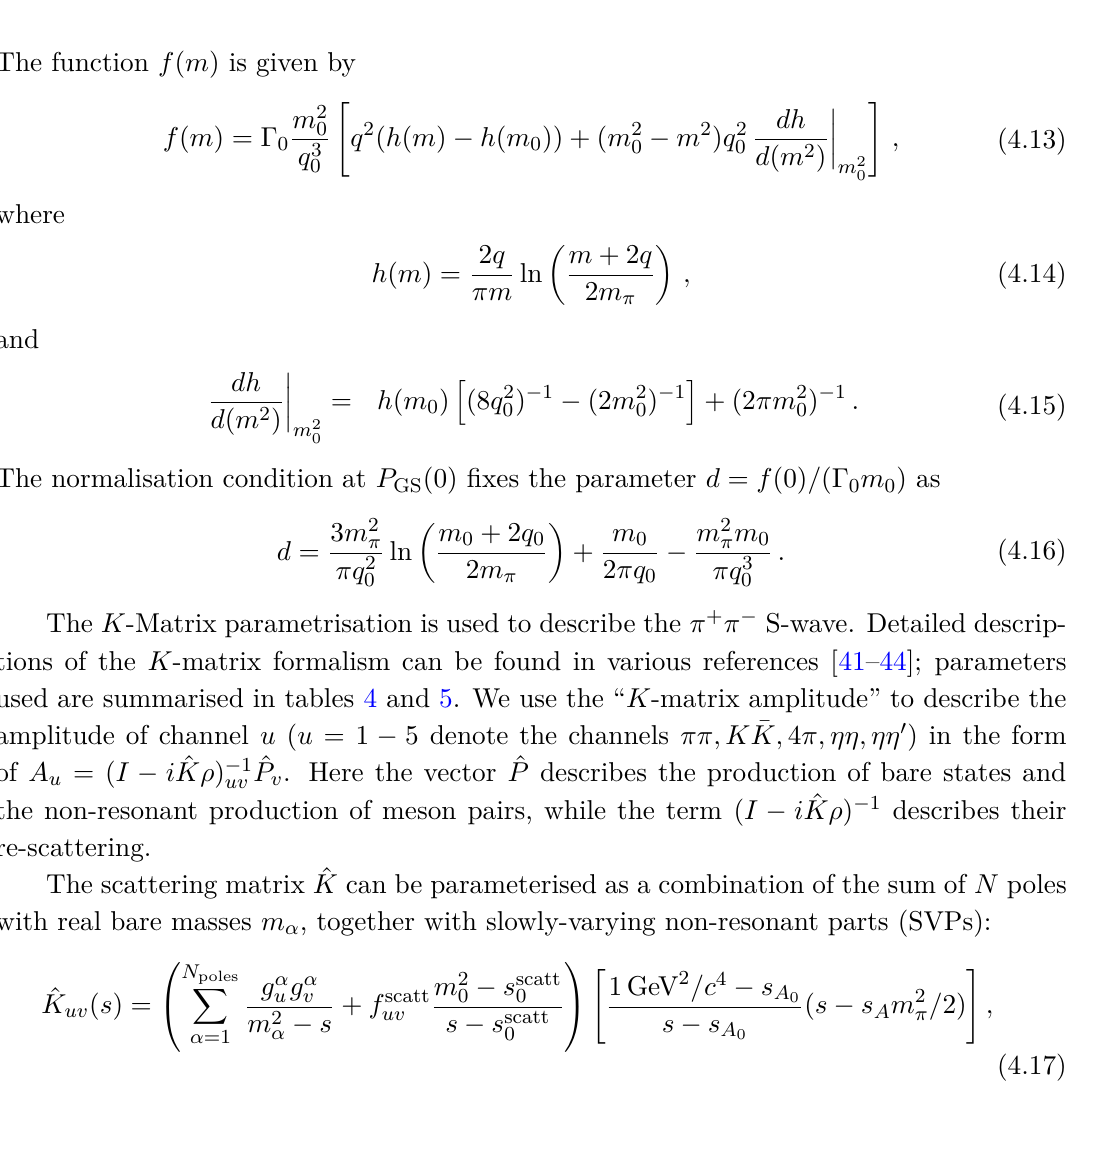
Table 4 . K-matrix parameters from a global analysis of the available ππ scattering data from threshold up to 1900 MeV/ c 2 . Masses and coupling constants are given in GeV/ c 2 .